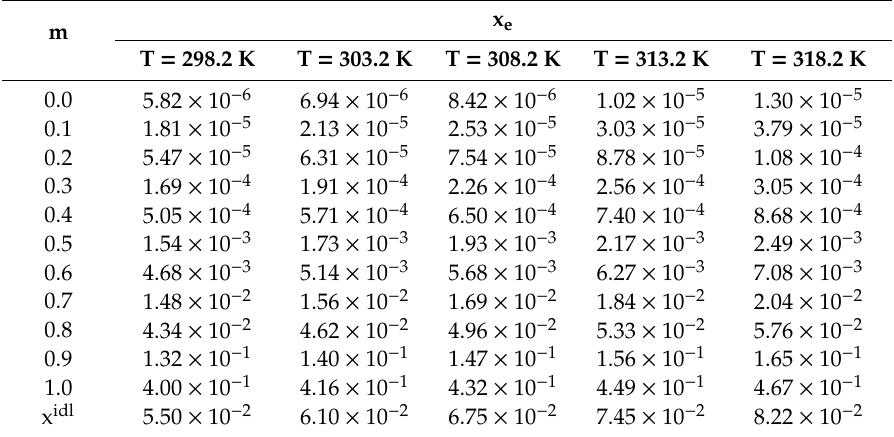
Table 1. The x e values of PPD against mass fraction value of DMSO ( m ) in binary DMSO + water mixtures at T = 298.2 K to 318.2 K and p = 0.1 MPa a